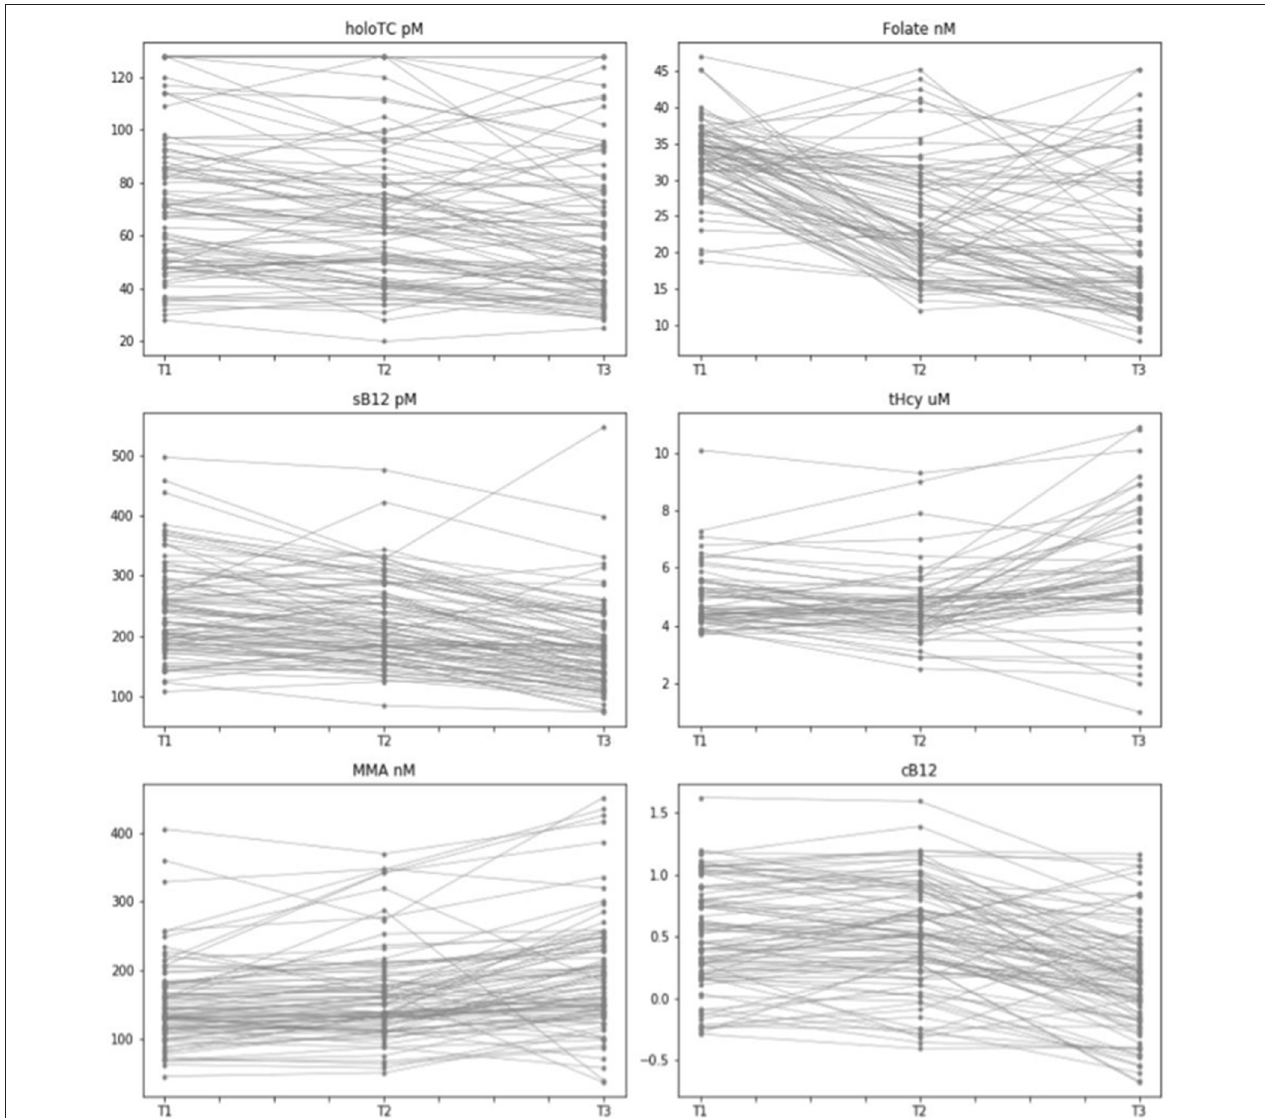
FIGURE 3 | Intra- and Inter-individual variability of vitamin B 12 biomarkers measured across the three trimesters of pregnancy. Graphical representation of pregnant women with data points for biomarkers of vitamin B 12 status across the three trimesters of pregnancy (T1, T2, T3), indicating consistency of behavior for each biomarker for each individual of this dataset. Biomarkers include Holo TC (pmol/L), serum folate (nmol/L), serum B 12 (pmol/L), tHcy ( µ mol/L), MMA (nmol/L), and cB 12